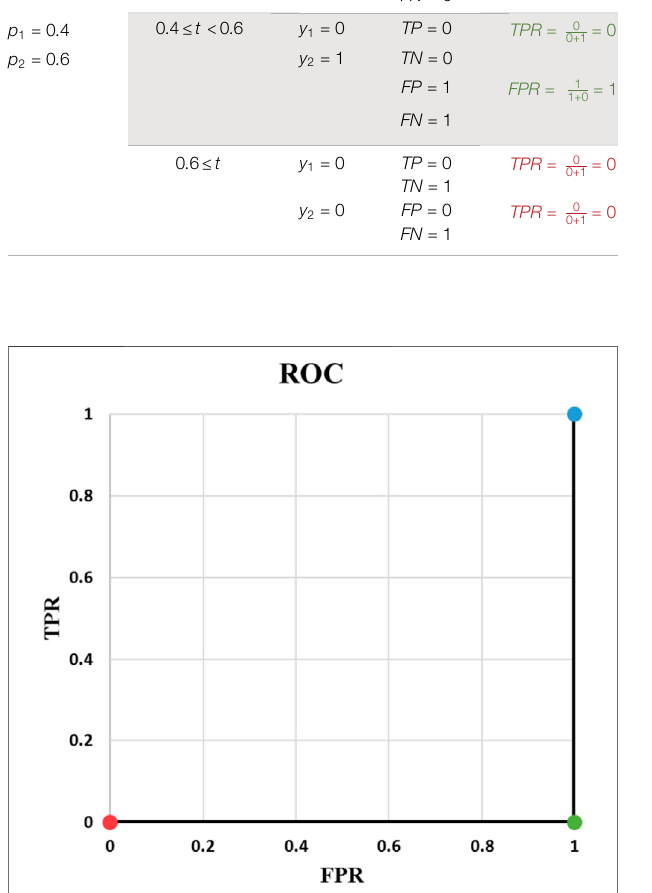
FIGURE 1 | ROC of Example 2.